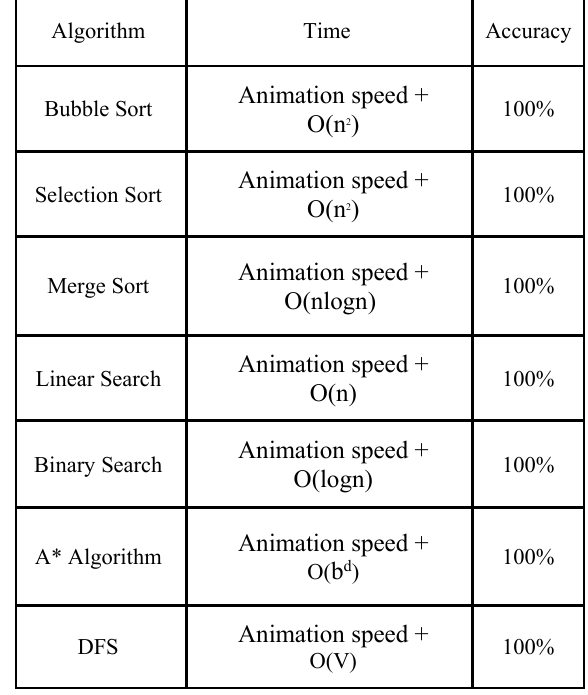
Table 1. Performance Analysis